Question: Write a single sentence explaining what this figure depicts.
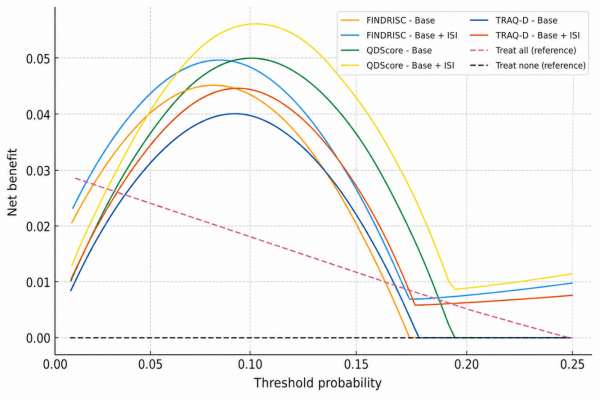
Answer: Decision Curve Analysis (Base versus Base+ISI). ISI, Insomnia Severity Index; FINDRISC, Finnish Diabetes Risk Score; QDScore, QResearch-derived Diabetes Risk Score; ref, reference; TRAQ-D, Trinidad Risk Assessment Questionnaire for Type 2 Diabetes Mellitus.